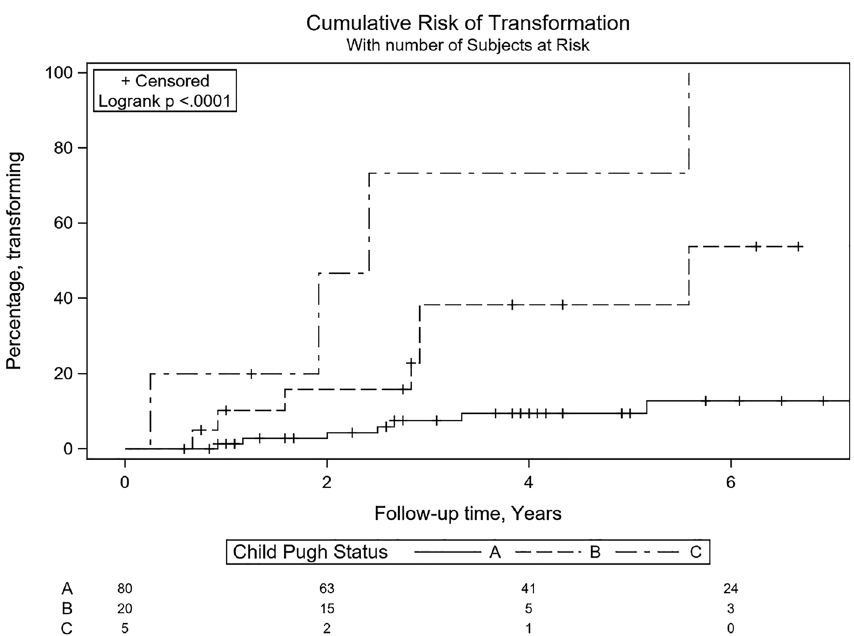
Figure 2. Cumulative probability curve of transformation of hypervascular nodules to hepatocellular carcinoma according to Child–Pugh